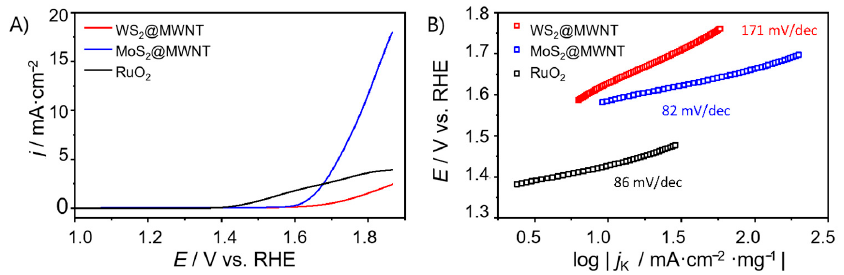
Figure 5. ( A ) OER polarization curves obtained by LSV (O 2 -saturated 0.1 mol · dm − 3 KOH, v = 0.005 V·s − 1 , 1600 rpm) for WS 2 @MWNT, MoS 2 @MWNT and RuO 2 , and ( B ) respective Tafel plots.